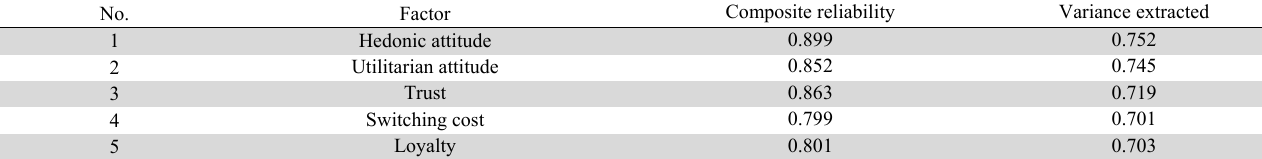
Composite reliability and Variance extracted